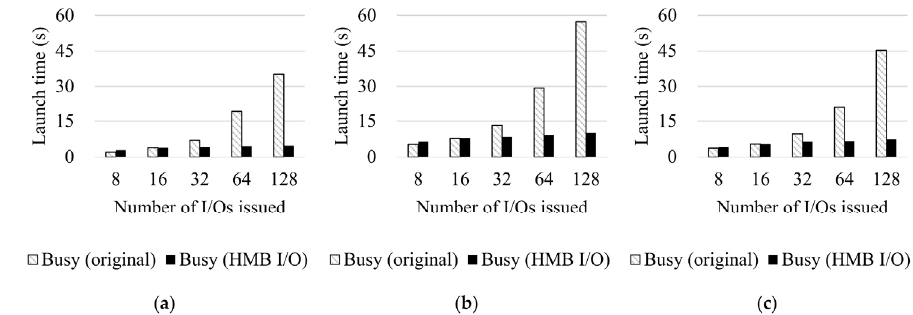
Figure 12. Launch time of applications. ( a ) Firefox; ( b ) Visual Studio Code; ( c ) ATOM.